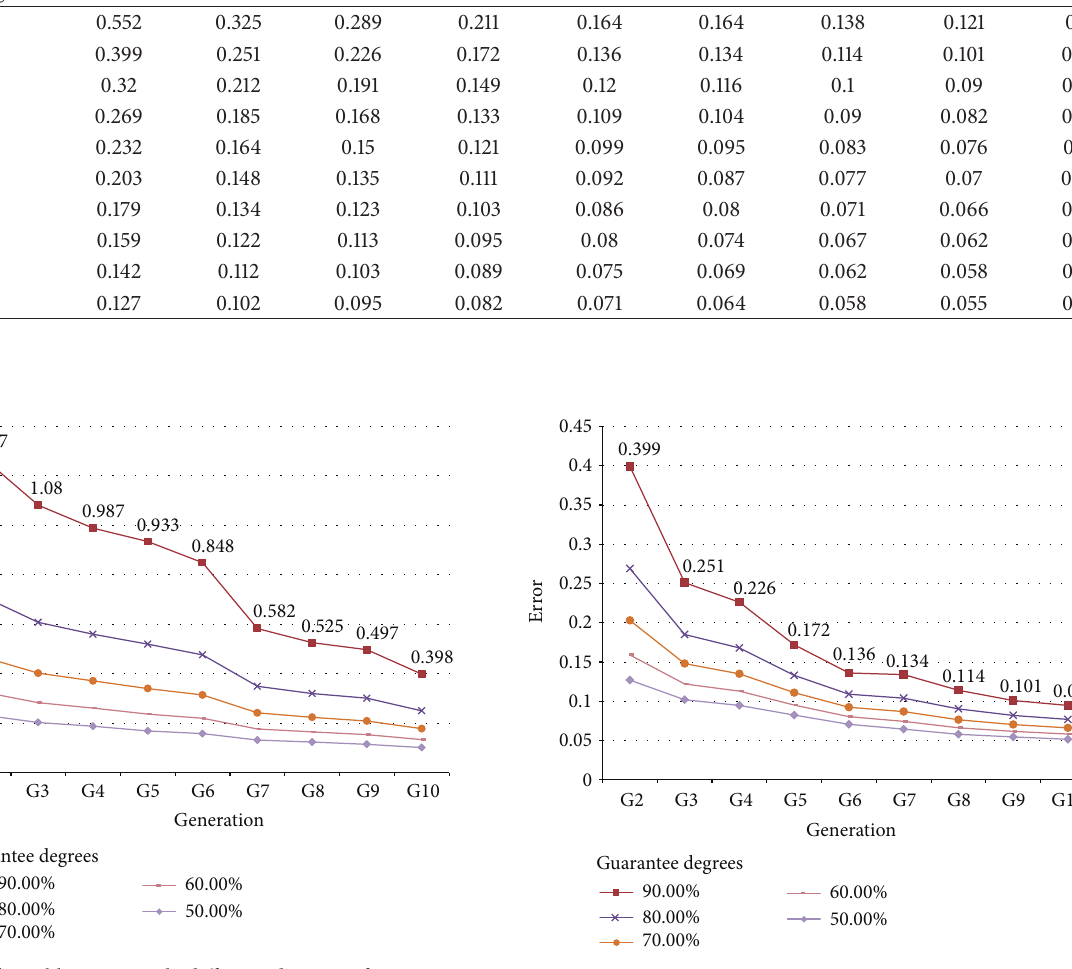
Figure 6: Achievable error with different degrees of guarantee. Populations composed of 25 individuals.